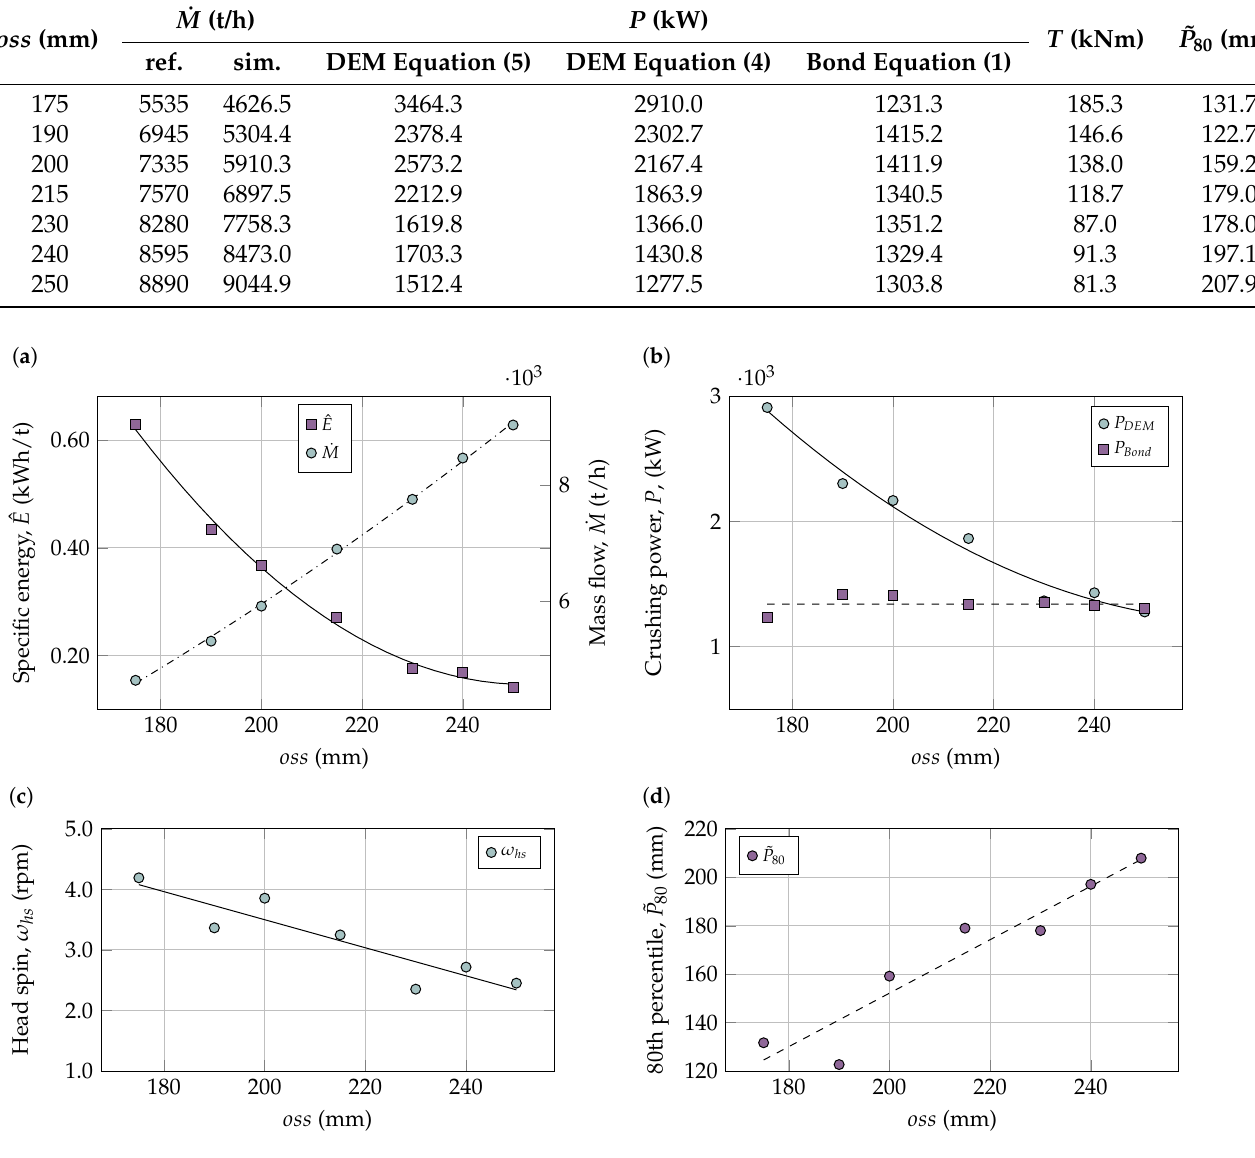
Figure 11. Results of simulations changing the open side setting: ( a )mass flow rate and specific energy, ( b )power comparison with Bond, ( c )head spin, and ( d )80th percentile of the product size